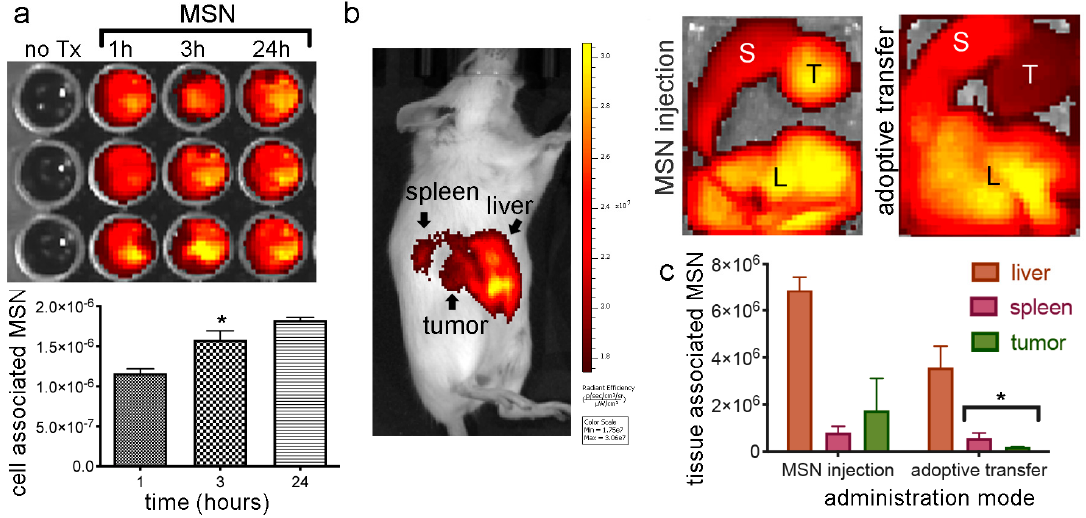
Figure 7. In vivo MSN biodistribution following direct injection or adoptive transfer via splenocytes. ( a ) IVIS Spectrum acquired images and analysis of DyLight 800 MSN uptake by BALB / c splenocytes at 1, 3, or 24 h (fluorescent images and graphed means with standard error bars). ( b ) BALB / c mice injected with DyLight 633 or 800 MSN (nanoparticles; NPs) were imaged at 24 h post-injection using the IVIS Spectrum (L, liver; S, spleen; T, tumor). Images of excised organs from mice injected with free MSN or MSN-loaded splenocytes (cells). ( c ) Average fluorescent intensity of organs ( n = 3 mice / group) presented graphically 24 h after injection of free MSN or MSN-loaded splenocytes. * p <